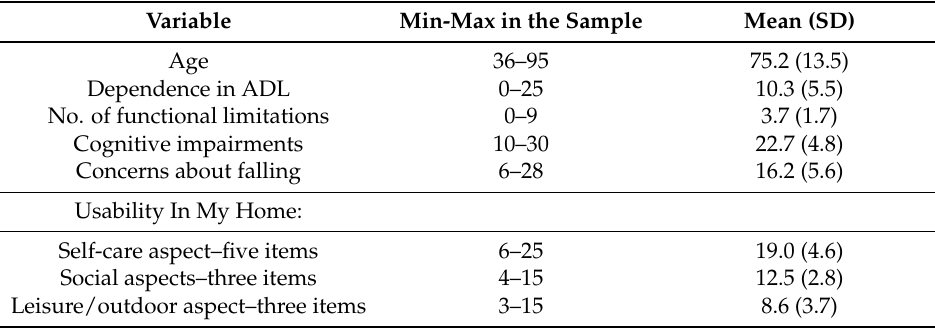
Table 1. Participant characteristics, N =